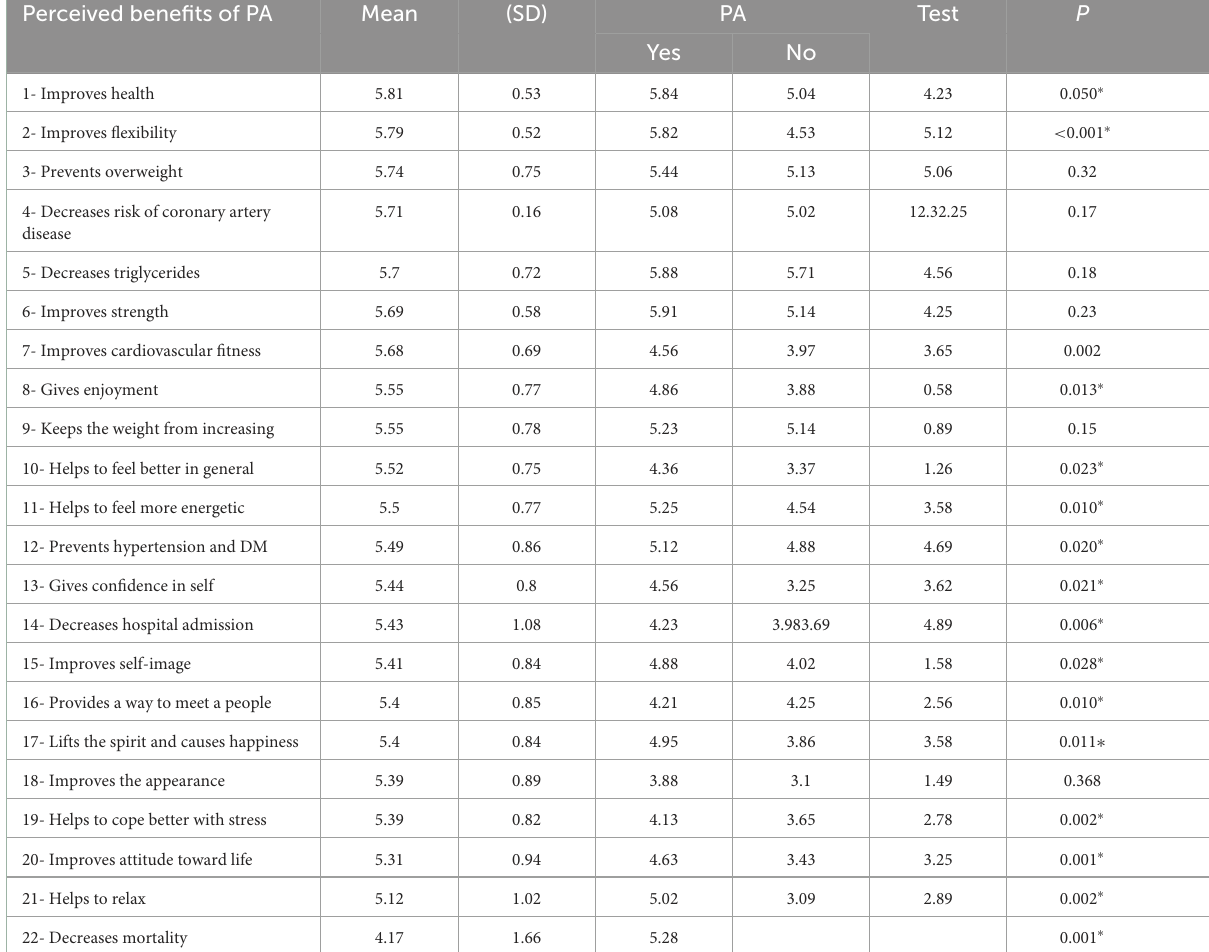
TABLE 5 Benefits of physical activity as perceived by Jordanian patients with CHD. Perceived benefits of PA Mean (SD) PA